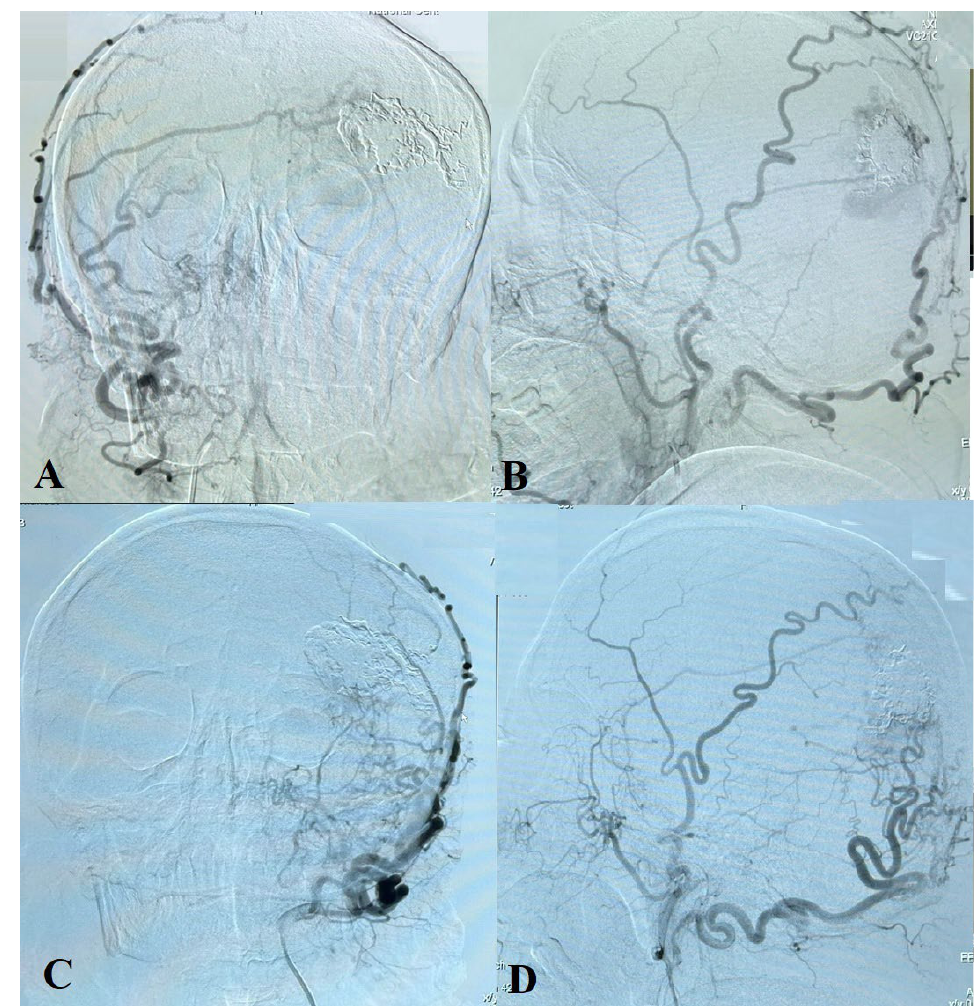
Figure 6. carotid angiogram from the right ICA ( A , B ) and from the left ICA ( C , D ) demonstrates the AVM’s embolized superior, inferior, and lateral parts. Many small afferents are seen from the occipital, superficial temporal, and meningeal arteries.